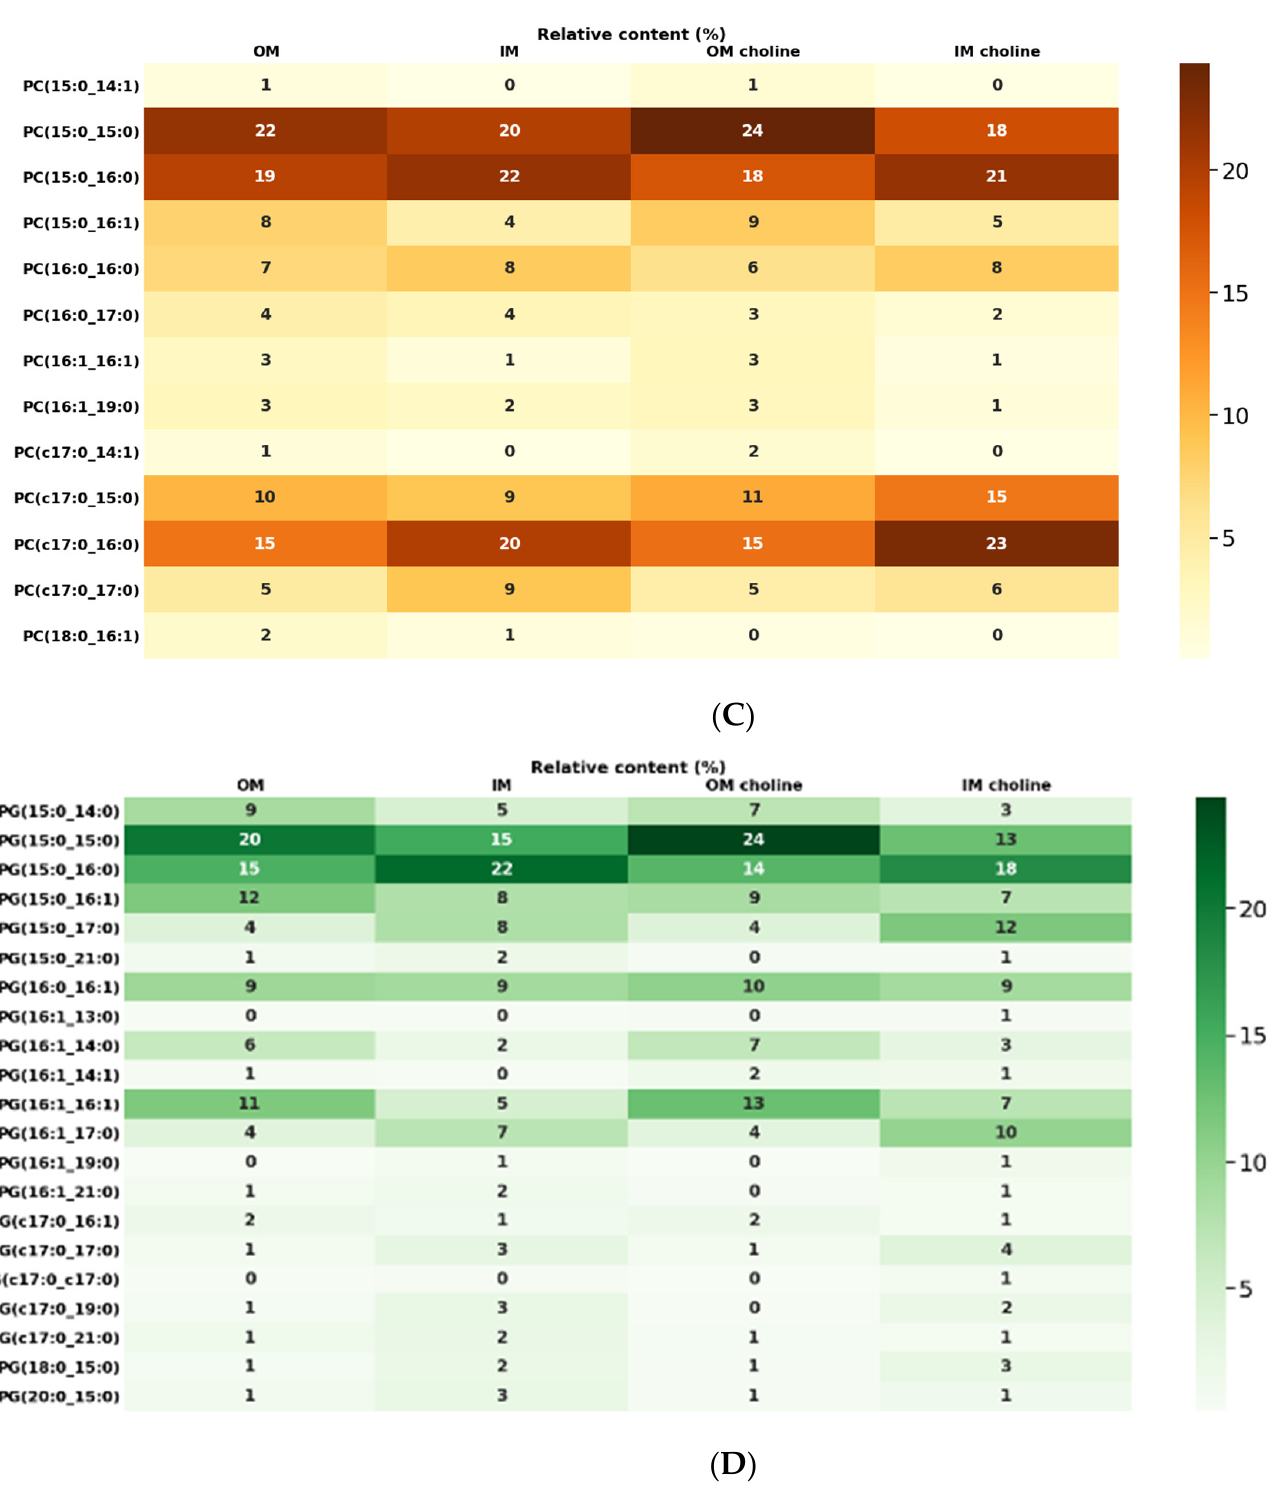
Figure 3. Heatmap displaying the relative abundances of PE ( A ), dMePE ( B ), PC ( C ), and PG ( D ) molecular species in total lipid extracts of the OM and IM of L. gormanii cultured on the standard medium and with exogenous choline. PE, PC and PG were analyzed by LC-MS(/MS) in the positive ion mode. The phospholipid class dMePE was analysed by LC-MS(/MS) in the negative ion mode.